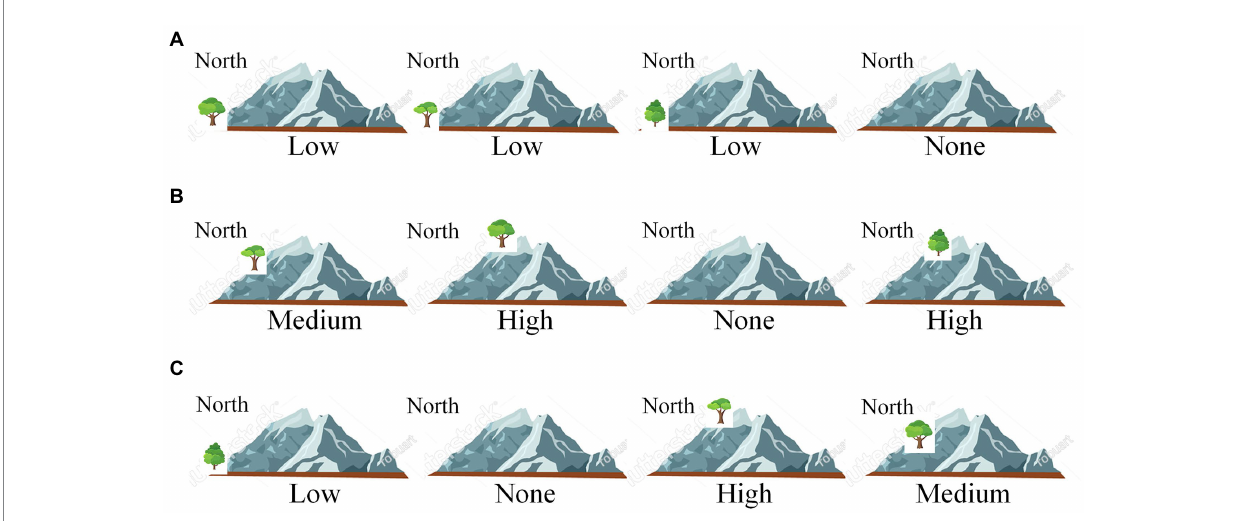
FIGURE 2 Example answers of the fair test 1. “Low,” “Medium,” “High” denote tree positions (foot, side, peak) in the northern ridge of a virtual mountain. “None” means no tree planted. In (A) , the first “Low” indicates that one type of trees is planted at the foot of the mountain, the second and third “Low” indicate that the other two types of trees are planted on the second and third mountains, and “None” means that the fourth mountain has no trees planted. Since the scoring rubric (see Table 2) does not specify tree type and ignores the mountain without trees, submitted answers can be simply denoted by the tree positions in the mountains with trees. In this way, answer (A) can be denoted as “Low; Low; Low”, answer (B) as “Medium; High; High”, and answer (C) as “Low, High, Medium”.